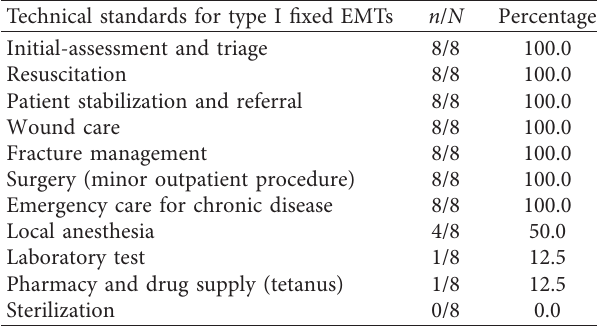
Table 2: The rates of compliance with the basic technical standards for each DMAT (a total of eight